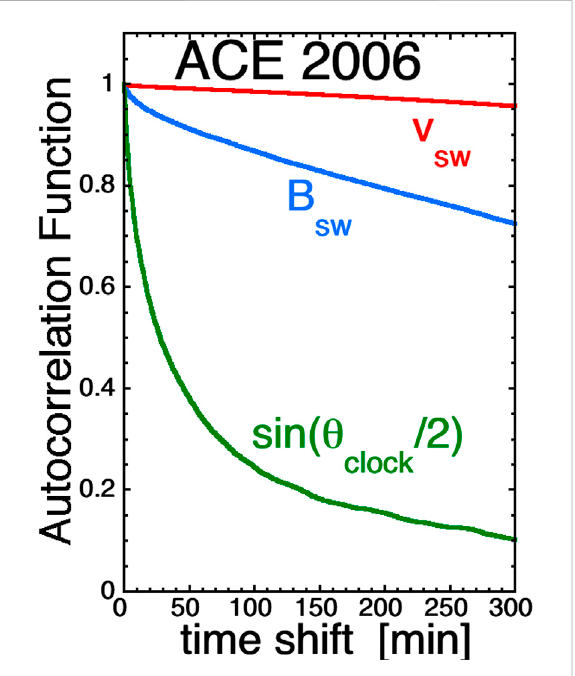
FIGURE 4 Autocorrelation functions for the three solar-wind variables v sw (red), B sw (blue), and sin( θ clock /2) (green) calculated using 64-s measurements from ACE for the year